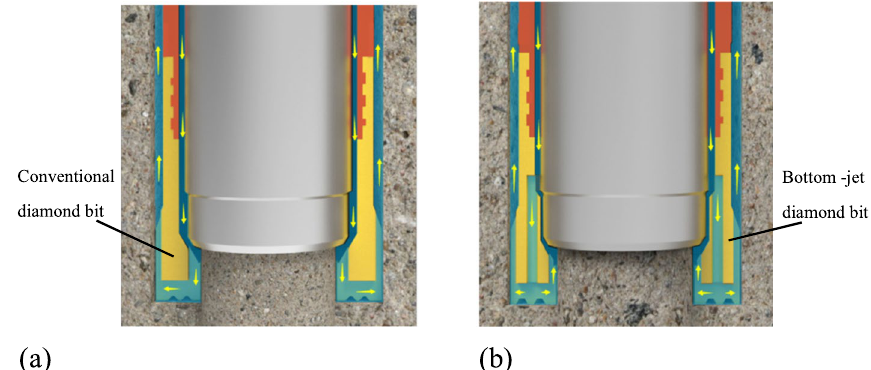
Fig. 2 Difference of water passage between two diamond bits. a Conventional water passage diamond bit. b Bottom-jet water passage diamond